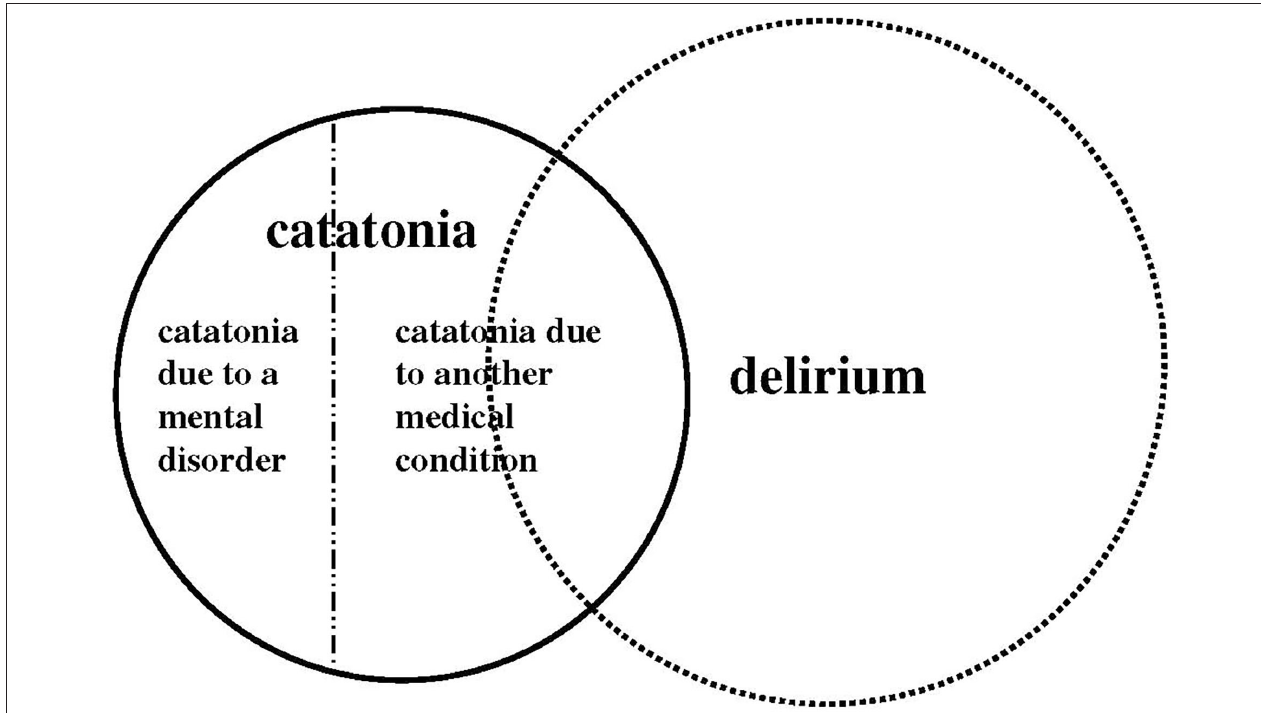
FIGURE 1 | Schematic image of the overlap of symptoms between catatonia and delirium according to the DSM-5 diagnostic